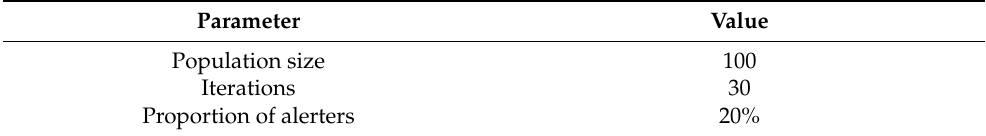
Table 4. CMASSA initial parameters. Parameter Value Population size